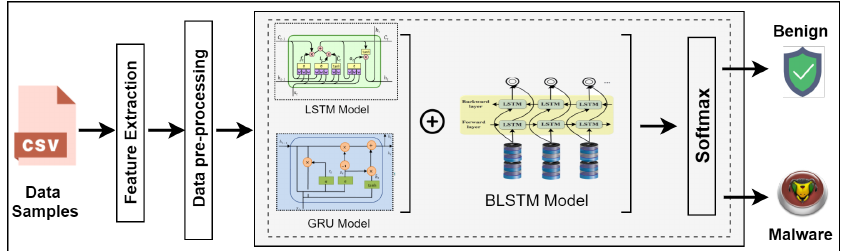
Figure 2. Detection